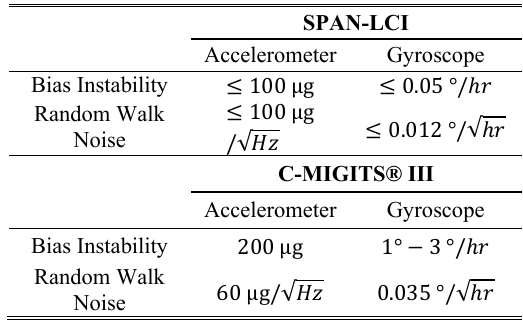
Table 1. Performance characteristics of C-MIGITS and